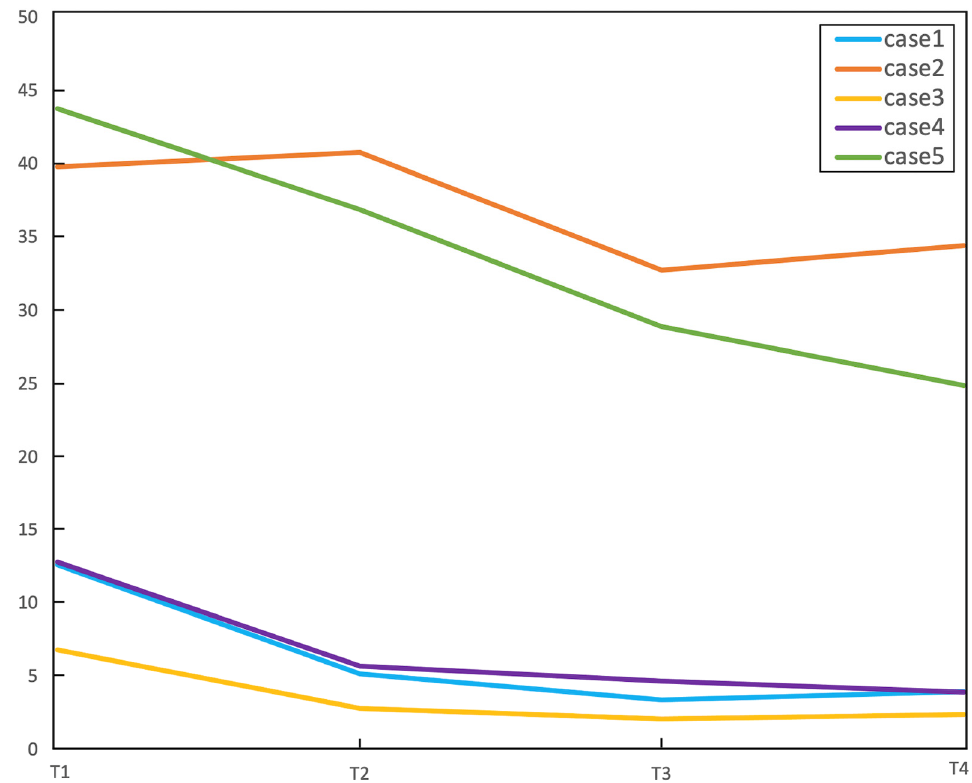
Figure 1. Tumor size over time for the five patients included in the study. Tumor size was measured as the product of the two greatest diameters on FLAIR images (cm 2 , y axis). Case 2 and 5 (described as possible ‘tumor-induced’ plasticity) presented larger tumor size at pre-op. T1 = baseline, T2 = post-op1 (4–8 months), T3 = post-op2 (10–14 months), T4 = post-op3 (16–23 months). Table 2. Treatment received by our patients during the follow-up period.